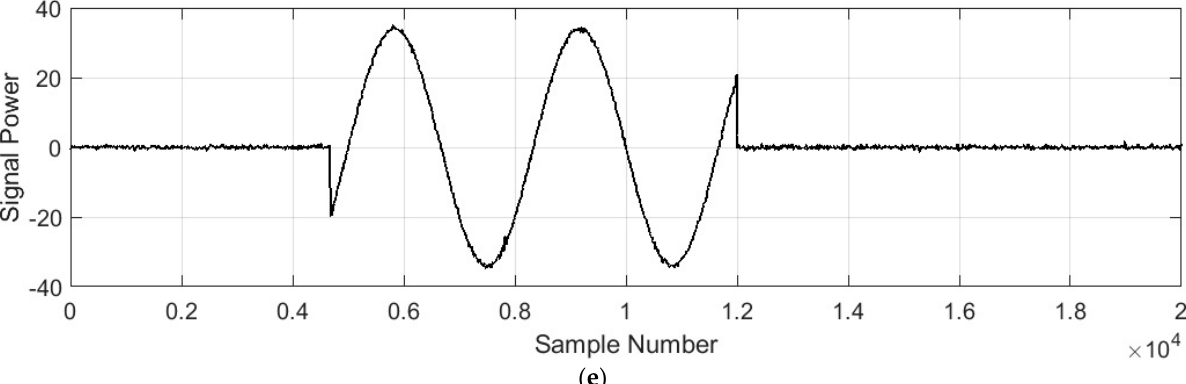
Figure 2. ( a ) Pure sag signal with 80% pu , ( b ) sag signal with 80% pu over the Gaussian plus impulsive noise channel (where µ = 400, ψ = 0.02%, and SNR = 35 dB), ( c ) extracted noise plus distortion component signal y [ i ] , ( d ) wavelet-based Gaussian-denoised distortion component signal ˆ y [ i ] , and ( e ) SM-filter-based impulsive-denoised distortion component signal (cid:101) y [ i ] .